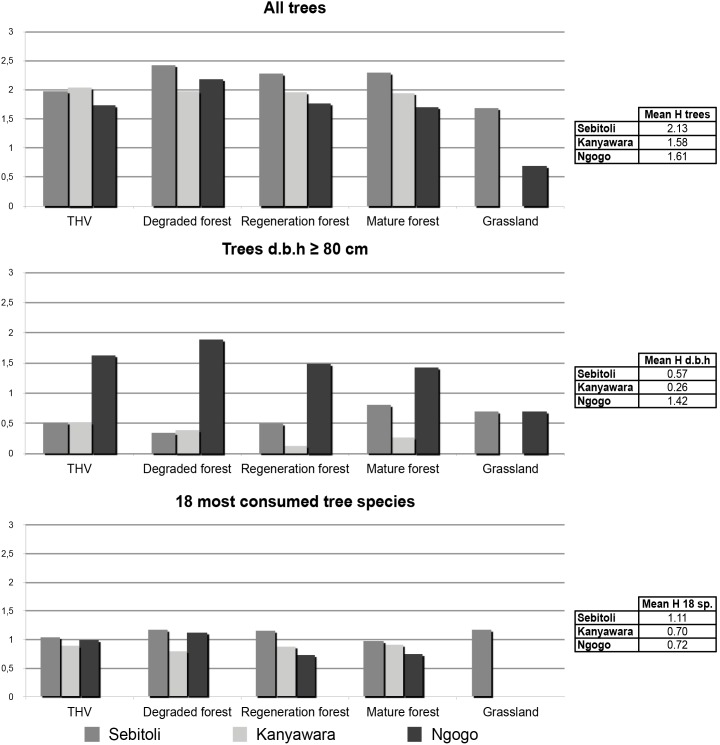
Diversity index in function of habitat types and vegetation characteristics.